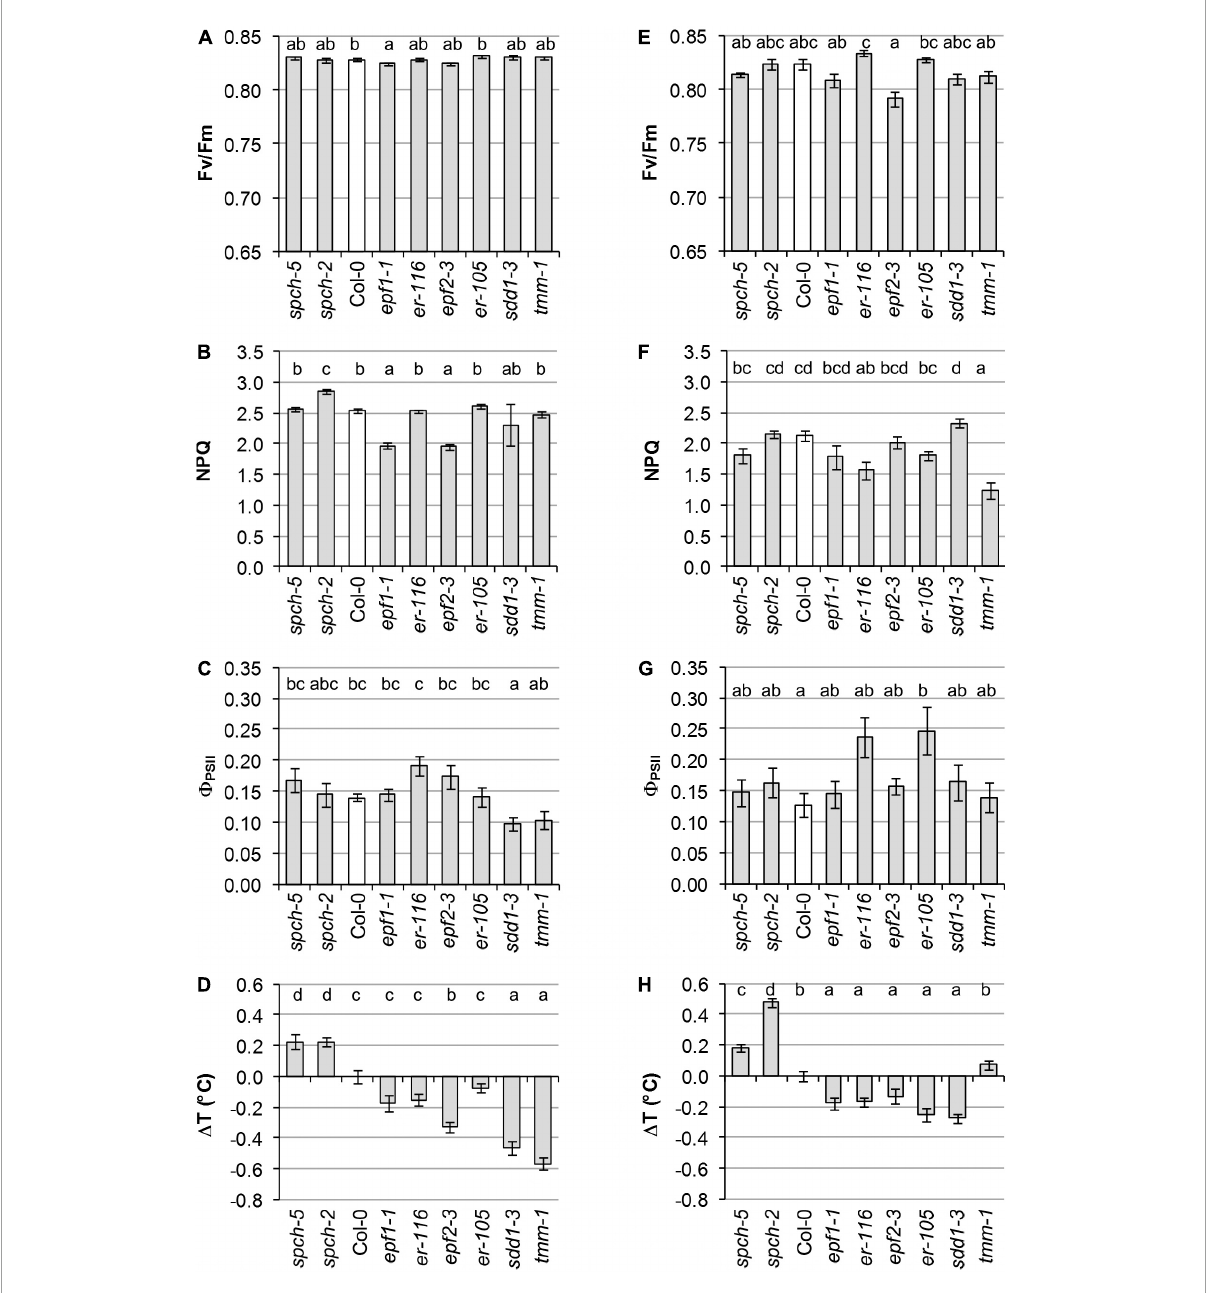
FIGURE2 Physiological performance of different stomatal abundance genotypes. Measurements were performed in cotyledons at 8 dag (A–D) and leaves at 23 dag (E–H) . (A,E) Photosynthetic capacity is evaluated in terms of maximal efficiency of PSII (F V /F M ). (B,F) The capacity for energy dissipation in the chloroplast is analyzed by the non-photochemical quenching in steady state (NPQ). (C,G) Photosynthetic activity is evaluated as quantum yield of PSII in steady state ( (cid:56) PSII ). (D,H) Alteration in temperature of cotyledons and leaves of mutant lines relative to the wild type. Values are means ± SE, calculated from n = 20 (A–D,H) and n = 12 (E–G) . Different letters above the bars indicate statistically significant differences between genotypes at the same growth temperature ( p ≤ 0.05) according to the Kruskal–Wallis test followed by the Dunn’s test (A–E,H) or one-way ANOVA followed by the Tukey’s test (F,G) .